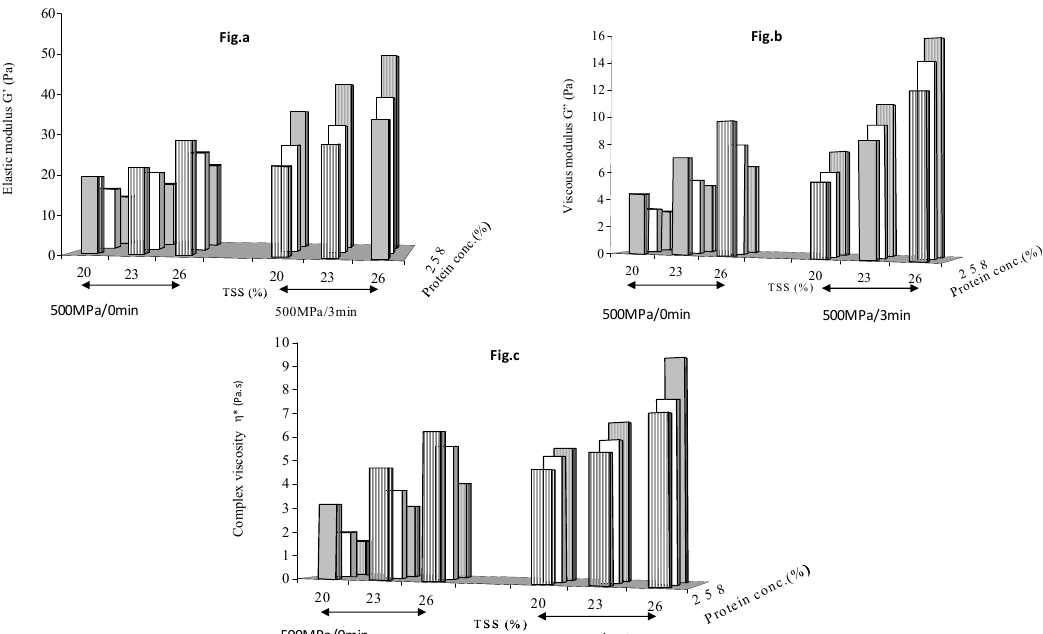
Figure 1. Effect of holding time (zero and 3 min) at 500 MPa on ( a ) elastic modulus ( b ) viscous modulus and ( c ) complex viscosity of protein enriched mango puree.